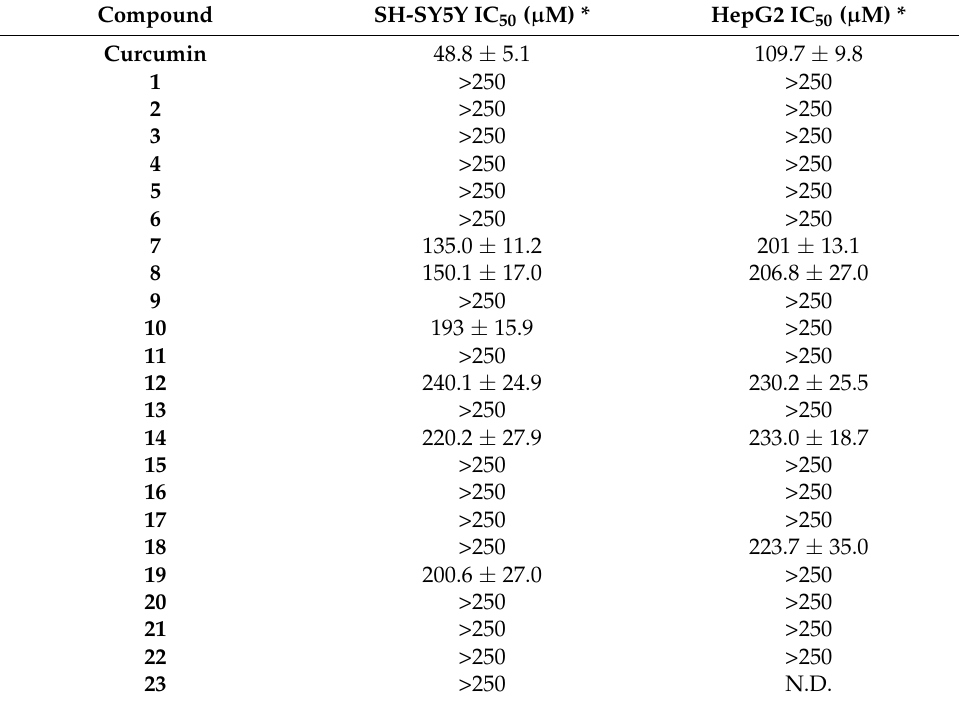
Table 4. Cytotoxicity of 1,5-Benzodiazepin-2(3 H